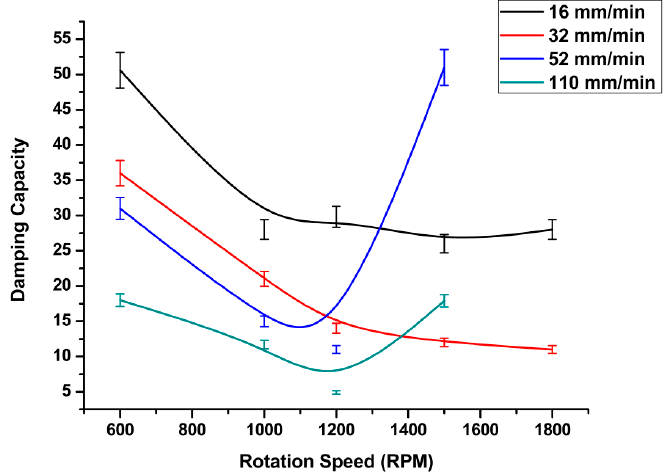
Figure 7. Effect of FSW processing parameters on damping capacity.